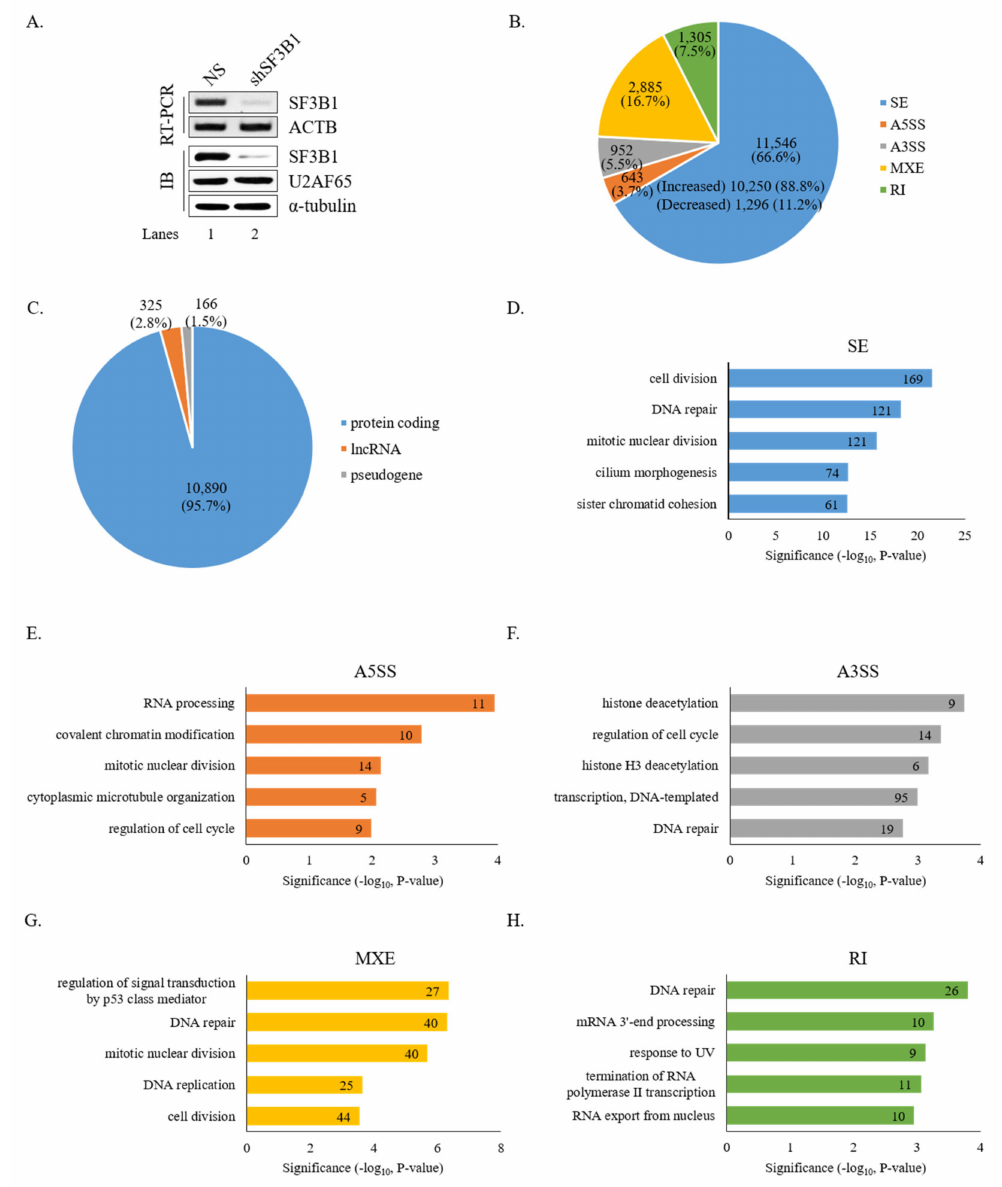
Figure 1. Global e ff ects of SF3B1 on AS based on RNA-seq. ( A ) Reduced expression of SF3B1 in HCT116 cells treated with an SF3B1-targeting shRNA or a non-silencing shRNA based on RT-PCR and immunoblotting using ACTB for RT-PCR and α -tubulin and U2AF65 for immunoblotting controls. ( B ) Pie chart of RNA-seq results showing alteration quantities of SEs, A5SS, A3SS, MXE, and RI in SF3B1 KD cells. ( C ) Pie chart of gene distributions of altered SEs in SF3B1 KD cells. ( D – H ) Gene ontology analysis of AS-regulated genes in SEs, A5SS, A3SS, MXE, and RI of SF3B1 KD